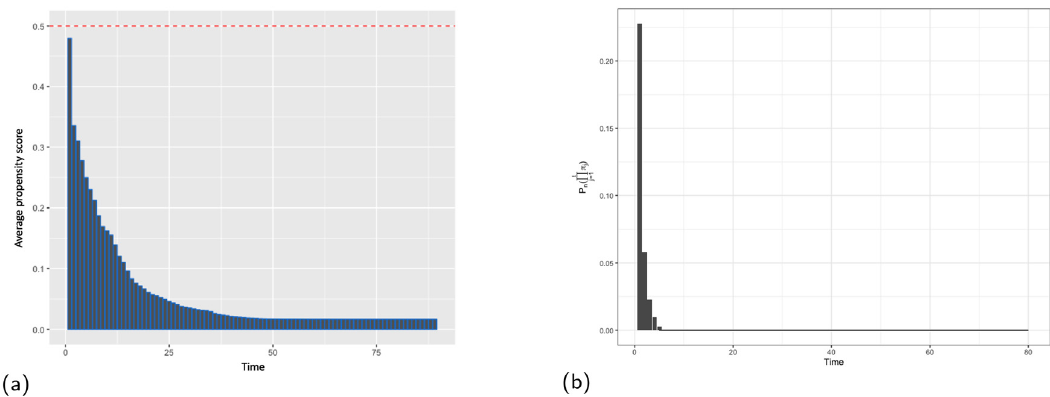
Figure A4: ( a ) The average propensity score over the course of follow - up. We observe that due to the noncomplinace, the average propensity score sharply decreases over time, which strongly hints at positivity violation in the EAGeR dataset. ( b )  (cid:3) ( ) ∏ over the course of follow - up. When t 5 ≥ , π n jt j π n jt j 1 = MSMs infeasible. We used Random Forests ( via the ranger package in R ) to estimate π